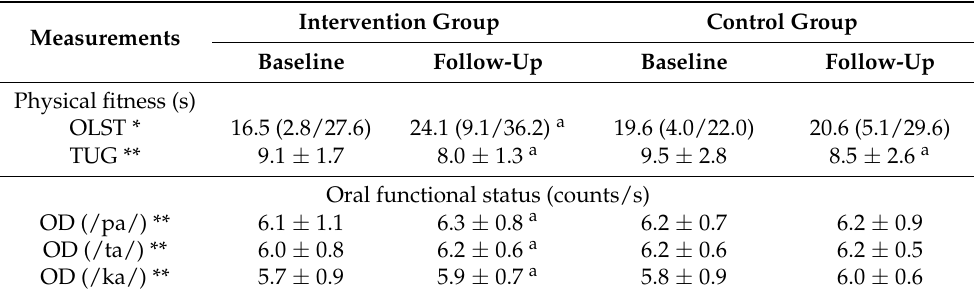
Table 2. Descriptive statistics for various physical fitness and oral function status measurements at the baseline and follow-up examinations.